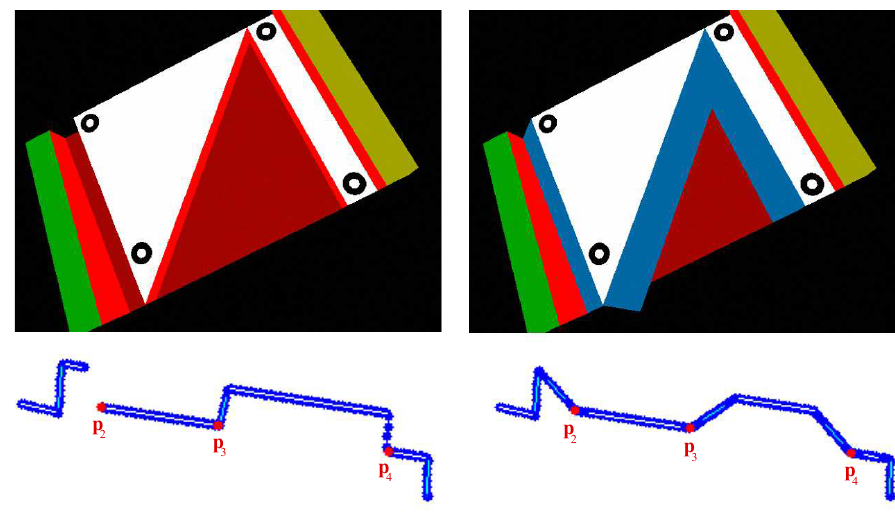
Figure 3. Comparison of laser depth readings between the original [9] ( left ) and our modified calibration object ( right